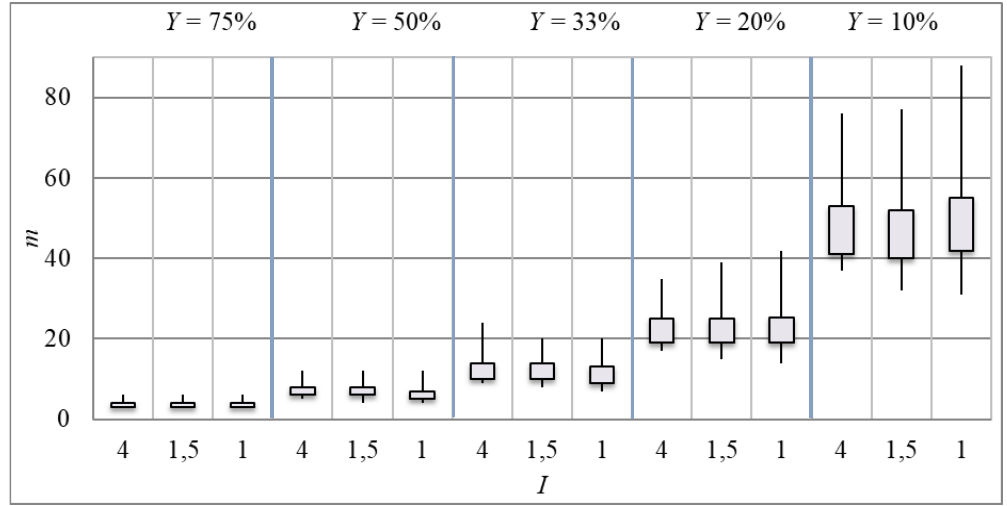
Figure 4. Box-and-whiskers diagrams for the number of negotiations m at the pre-defined power index of coalitions I and different concessions